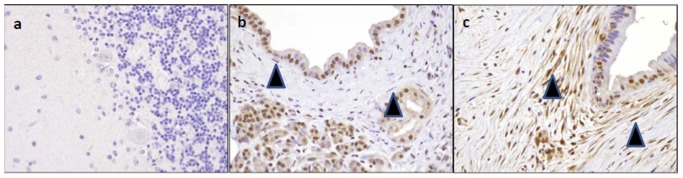
Immunohistochemical analysis of Adam12 protein expression in tissue microarrays.(A) Adam12 protein expression is undetectable in the granule cell layer of the brain (negative control tissue). (B) Stromal fibroblasts (arrows) surrounding normal pancreatic duct do not label Adam12. (C) Cancer associated fibroblasts (arrows) in a primary pancreatic adenocarcinoma are strongly positive for Adam12 protein; magnification, 20×.